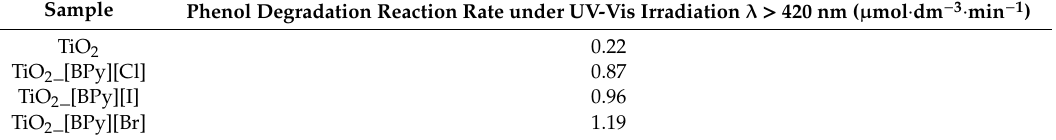
Phenol degradation reaction rates under visible irradiation for the samples: TiO 2